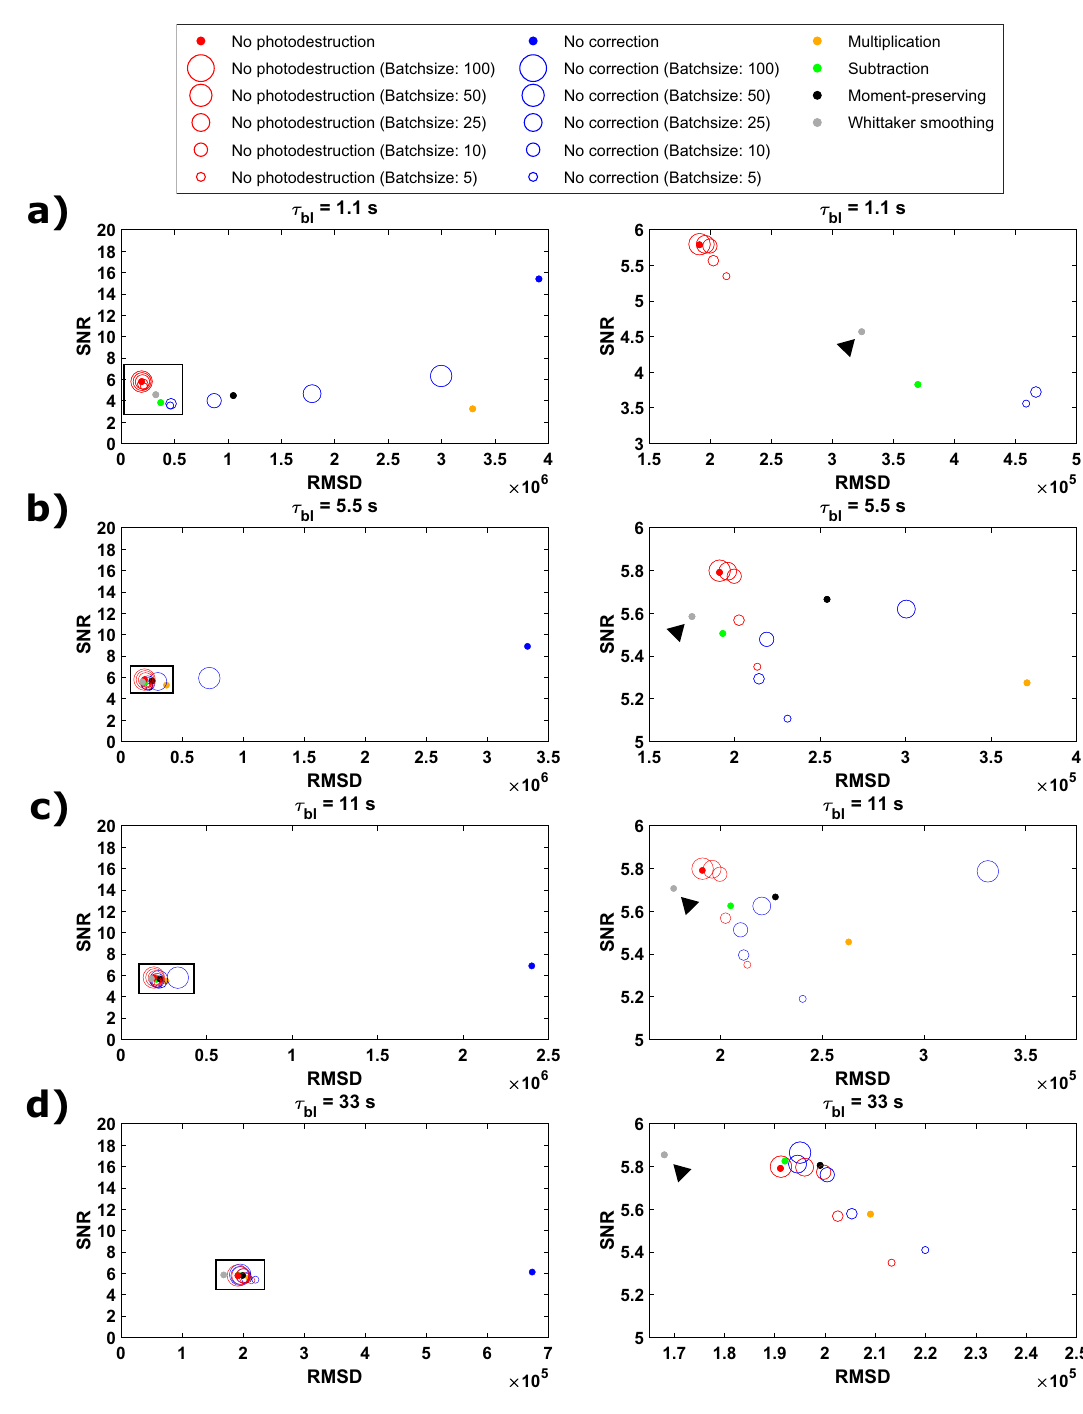
Figure 3. Evaluation of the proposed Whittaker smoothing correction method (indicated with an arrow) in comparison with previous results obtained as reported in previous work 24 . The obtained SNR and RMSD values by using second order SOFI analysis on four different sets of simulations with different photodestruction behavior, with survival times ( τ bl ) set at 1.1 s, 5.5 s, 11 s and 33 s are shown in panels ( a ) to ( d ), respectively. Correcting photodestruction with Whittaker smoothing gives extremely good results overall, but it especially has a big advantage over the other methods in situations where photodestruction is faster (panels a – b ). All results were obtained using Matlab R2018b (Mathworks,